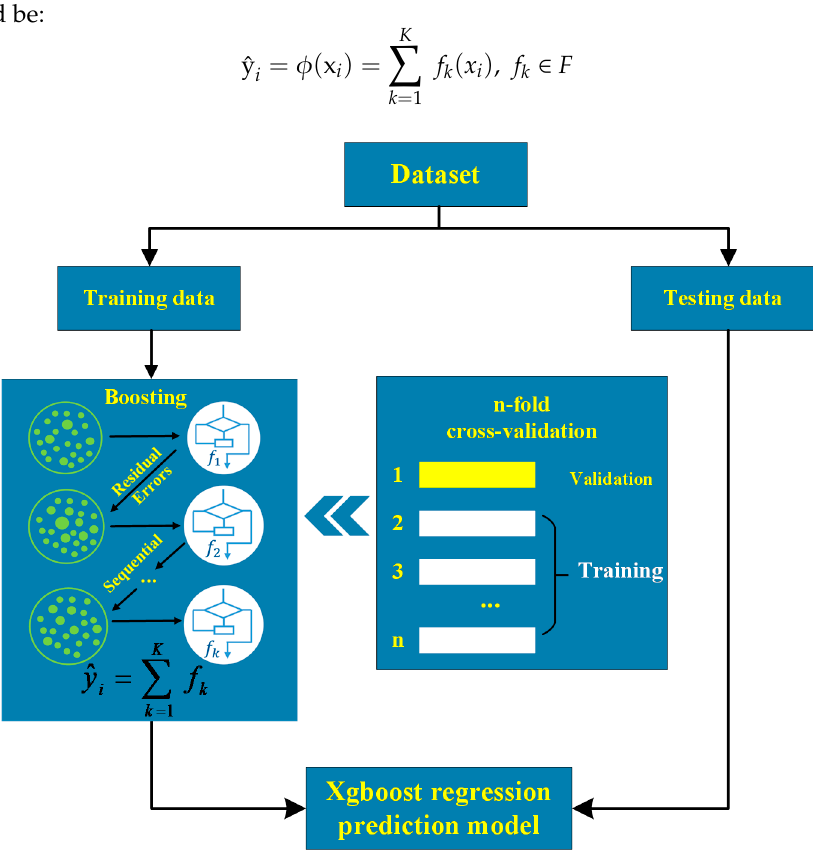
Figure 5. Schematic of XGBoost trees.